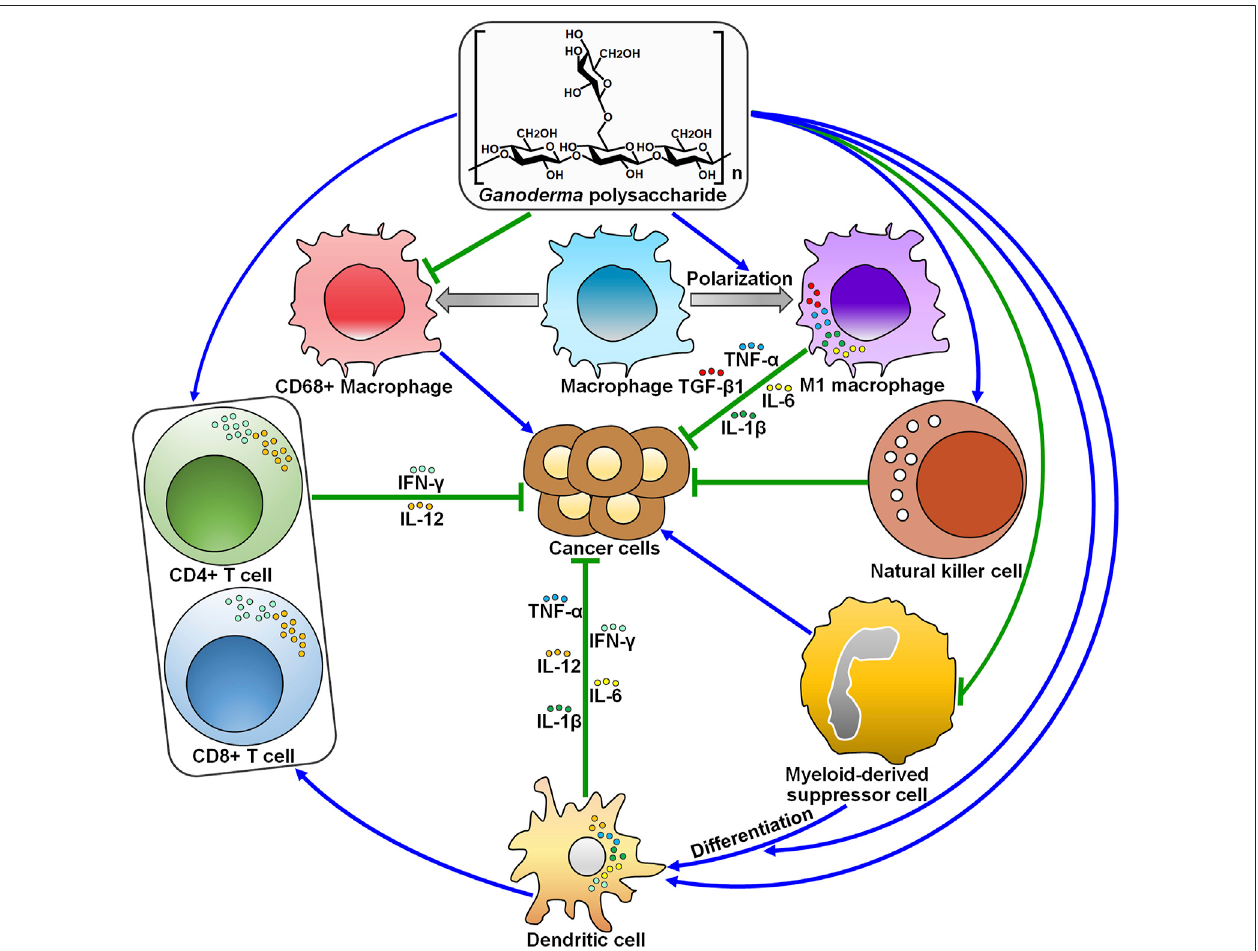
FIGURE 2 | The roles of Ganoderma polysaccharides in modifying antitumor immunity. Ganoderma polysaccharides inhibit the proliferation of pro-in fl ammatory CD68 + macrophages, while they promote macrophage polarization toward the antitumoral M1 phenotype. Ganoderma polysaccharides can enhance the cytotoxic activity of natural killer cells. Ganoderma polysaccharides suppress the accumulation of myeloid-derived suppressor cells and foster their differentiation into mature dendriticcells. On theotherhand, Ganoderma polysaccharides directlyactivate dendriticcells and favor theproduction ofcytokines (e.g., IL-1 β ,IL-6, IL-12, IFN- γ , and TNF- α ). Dendritic cells then present cancer-speci fi c antigens to CD4 + T cells, thus recruiting CD8 + T cells to eliminate cancer cells. IFN- γ , interferon- γ ; IL-12, interleukin-12; TNF- α , tumor necrosis factor- α ; TGF- β 1, transforming growth factor- β 1; IL-6, interleukin-6; IL-1 β , interleukin-1 β